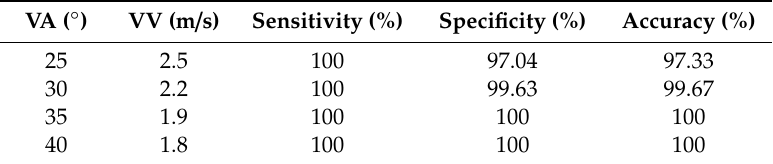
Figure 6. Accuracy determined using VA and VV thresholds. Table 4. Lead times according to threshold combinations.